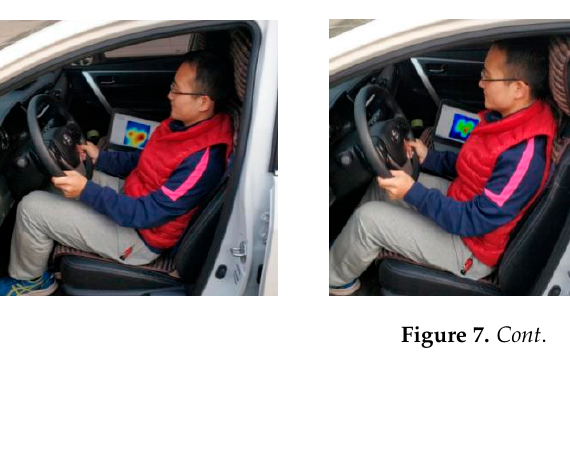
Table 1. Range of comfort and typical driving posture for the postural angle.